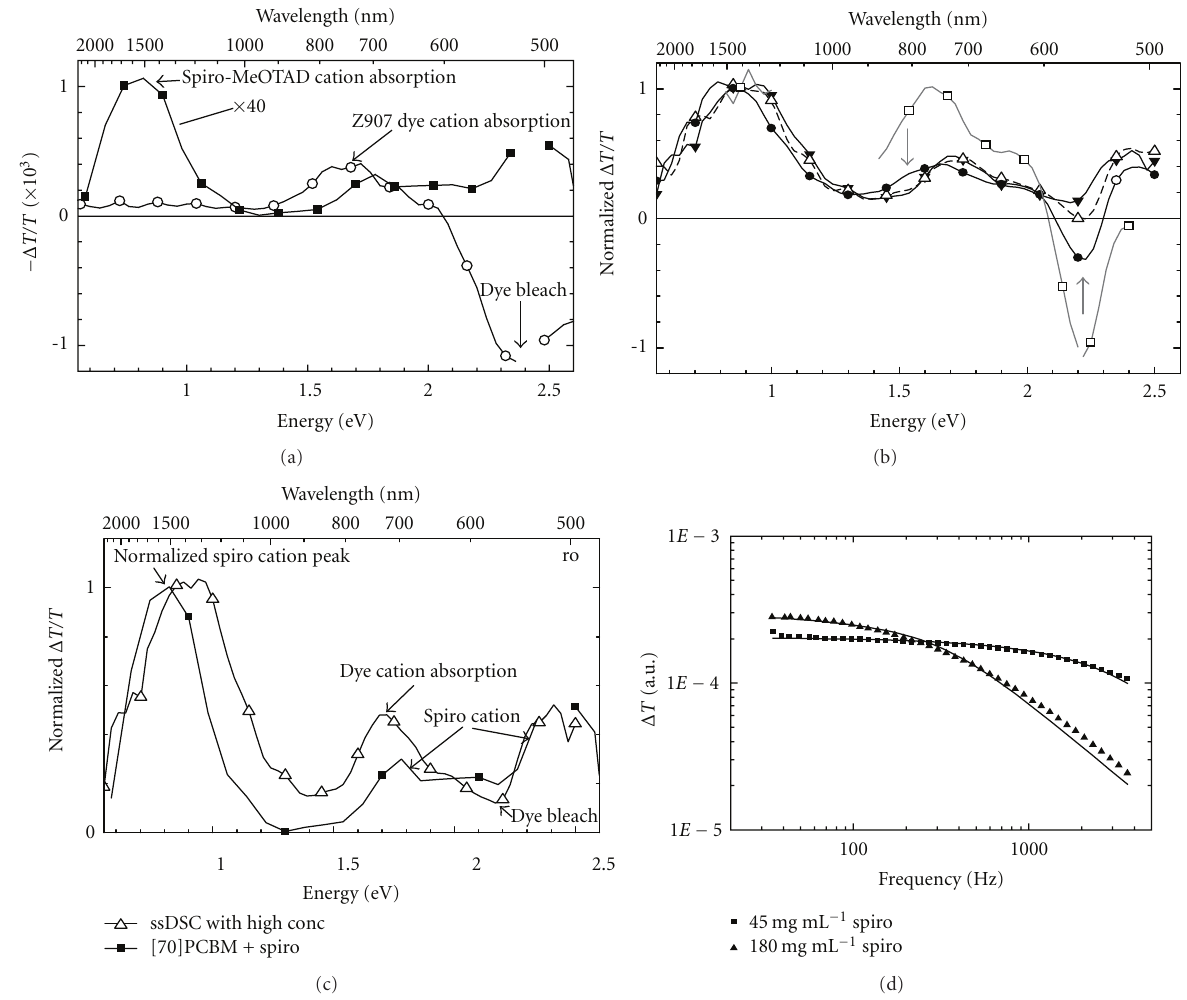
Figure 6: Photoinduced absorption spectra of (a) dye Z907 in TiO 2 ( (cid:6) ), and [70]PCBM blended with spiro-MeOTAD on TiO 2 ( (cid:2) , multiplied with a factor of 40); (b) TiO 2 sensitized with dye Z907, with spiro-MeOTAD, normalized at the peak at 1400–1500 nm (0.83– 0.89eV), using spiro-MeOTAD concentrations of 25 ( (cid:6) ),45 ( • ), 90 ( (cid:8) ), and 180 ( (cid:4) ) mgmL − 1 ; (c) spectrum of a ssDSC: sensitized (Z907) TiO 2 infiltrated with a high concentration of spiro-MeOTAD (200 mgmL − 1 ), ( (cid:8) ); compared with the spectrum of the spiro- MeOTAD/PCBM blend, ( (cid:2) ). Spectra were recorded using excitation wavelengths of 514 nm (a, c) and 458 nm (b, c). (d) Frequency- dependent PIA intensities for TiO 2 samples sensitized with dye Z907, infiltrated with 45 ( (cid:2) ) or 180 ( (cid:3) ) mgmL − 1 spiro-MeOTAD solution. The measurements were recorded at 1.05 eV (1180 nm). The solid lines are fits to the data (13) and result in steady-state lifetimes of 115 and 995 μ s for the low and the high spiro-MeOTAD concentration,